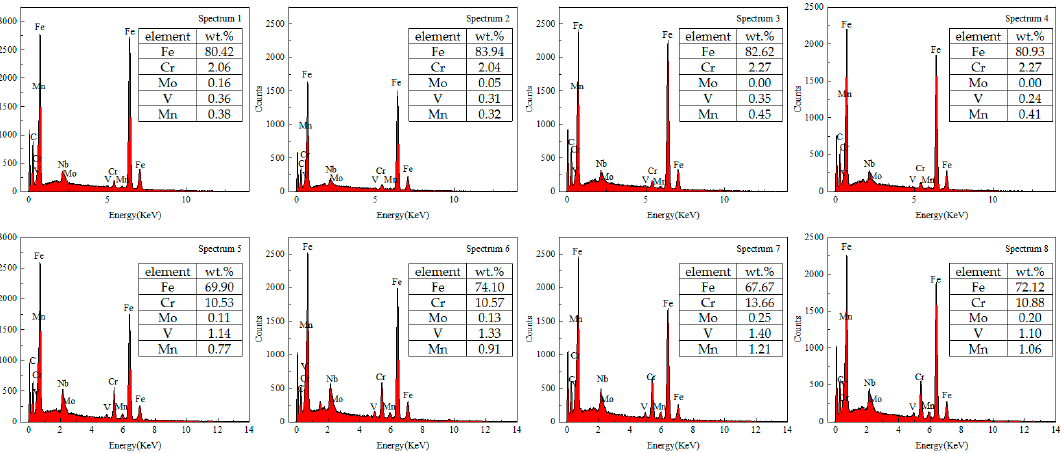
Figure 8. EDS spectra of spectrum 1 and 8 marked in Figure 9.